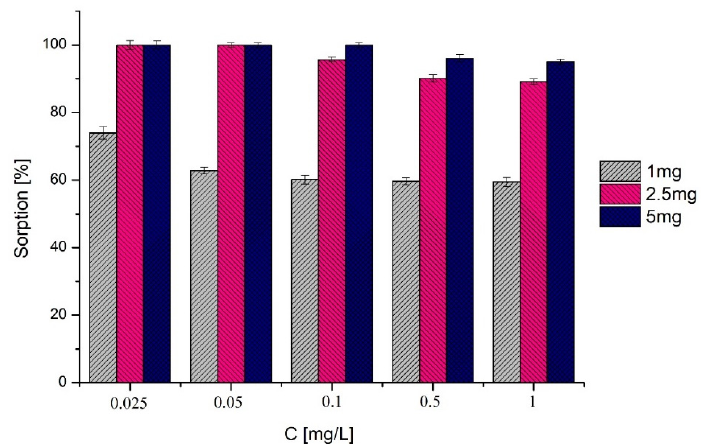
Figure 2. The effect of the initial concentration of BPA (0.025–1 mg · L − 1 ) and the amount of microgel on the sorption. Data are means with RSD ( n = 3).